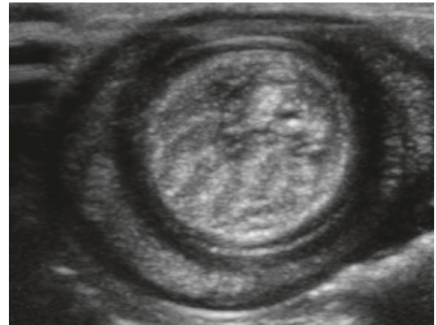
Figure 1: Short axis ultrasonographic image of the stomach demon- strating the typical target-like (multilayering) appearance seen in cases of